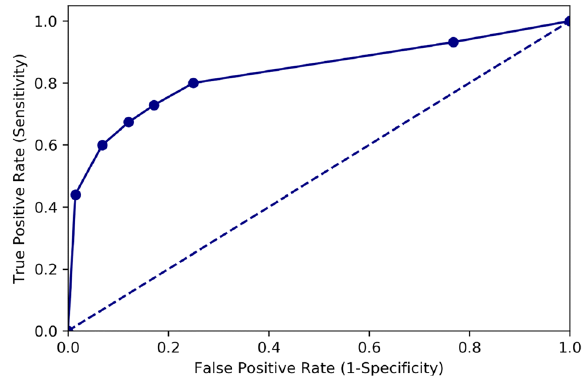
Figure 7. Analogous receiver operating characteristic (ROC) analysis of the UNet models obtained using batch control methods. The estimated area under the ROC curve is 0.83.